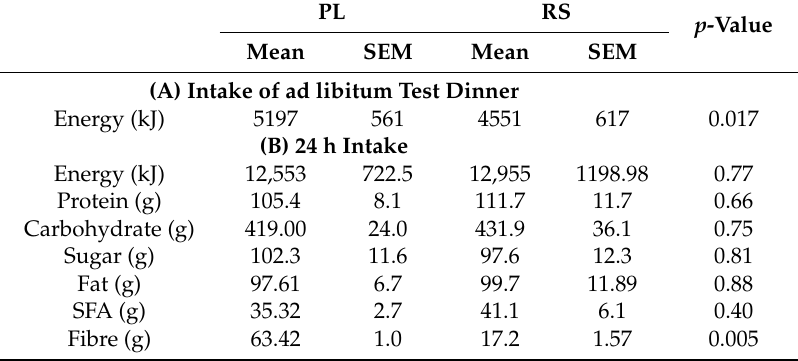
Table 3. Intake following supplementation with 48 g of resistant starch (RS) or matched placebo